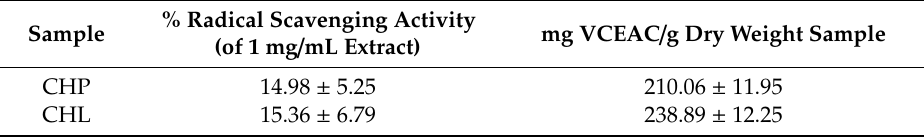
VCEAC: Vitamin C equivalent antioxidant capacity. Free radical scavenging activities of ethanolic extracts of CH using a 2,2 (cid:48) -azino-bis (3-ethylbenzthiazoline-6-sulphonic acid) (ABTS) scavenging assay.